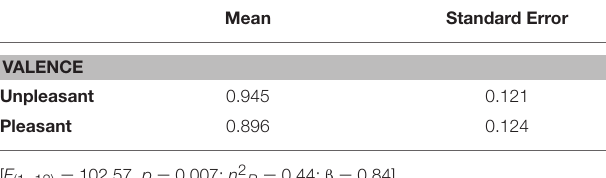
TABLE 2 | MEP values (mV) per experimental